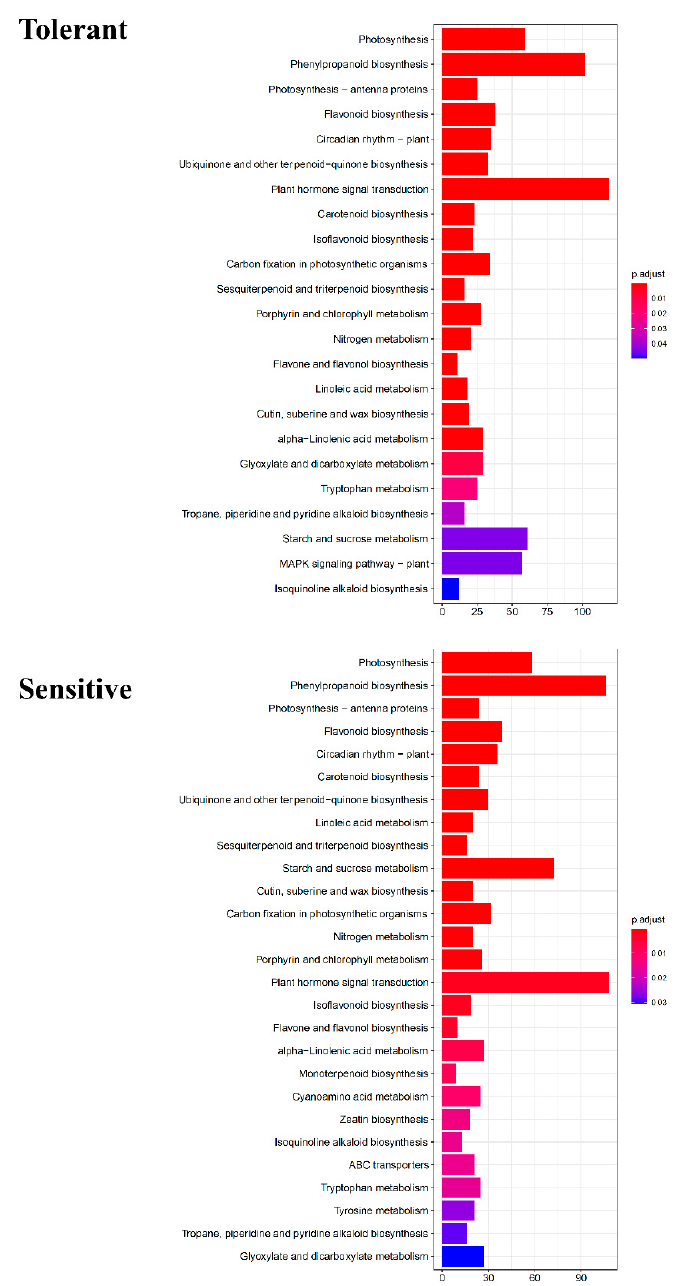
Figure 5. DEG enrichment of the metabolic pathway. There was a difference between the tolerant and sensitive genotypes in the number of genes enriched for the particular